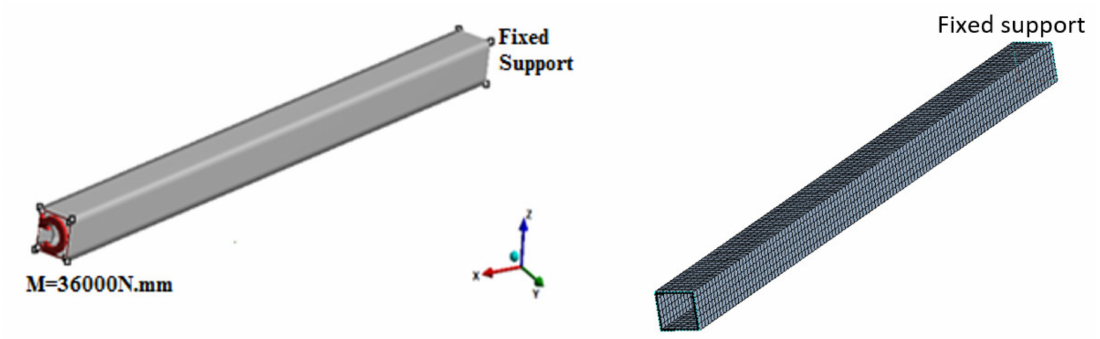
Figure 13. Applied boundary conditions and loading of beam subjected to torsional loading (FE models consist of up to ~61,000 nodes and ~57,400 elements depending on laminate thickness).